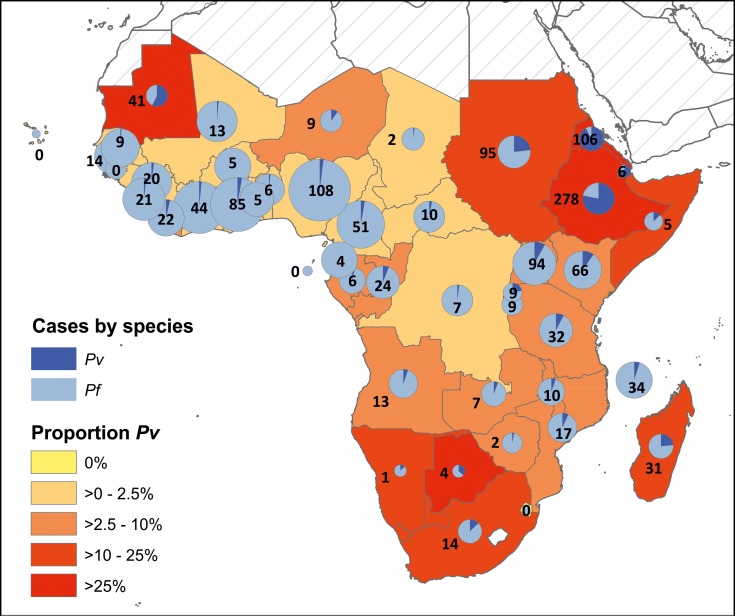
Traveller infections mapped to probable country of infection.The relative contribution of Pf and Pv infections is reflected in each pie chart (with charts sized by overall number of infections, transformed on a square-root scale). Numbers indicate the number of exported Pv infections identified by this study (corresponding to the dark blue segment of the pie chart). Infections date from 2000 to 2014; data sources and countries of importation are listed in Fig 1. Where species-specific information was available for mixed infections, these were considered to be separate infections, so a single individual would have contributed two or more infections to the total count of malaria parasite infections. Returning patients for whom a single country of probable infection could not be determined were excluded.